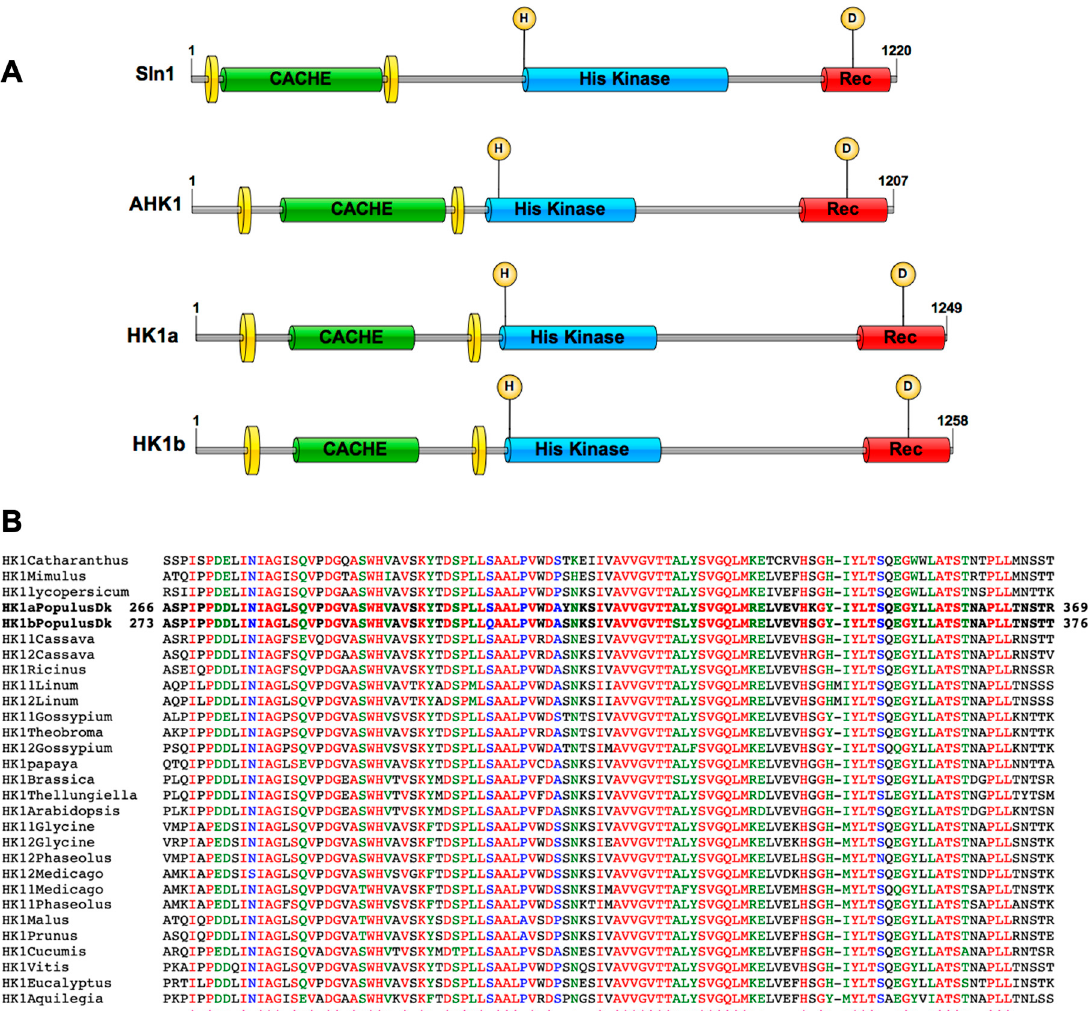
Figure 1. A cache domain is present in plant AHK1-like proteins. ( A ) Protein organization of Sln1 (Uniprot ID P39928), AHK1 (Uniprot ID Q9SXL4), HK1a (Uniprot ID Q571R6) and HK1b (Uniprot ID